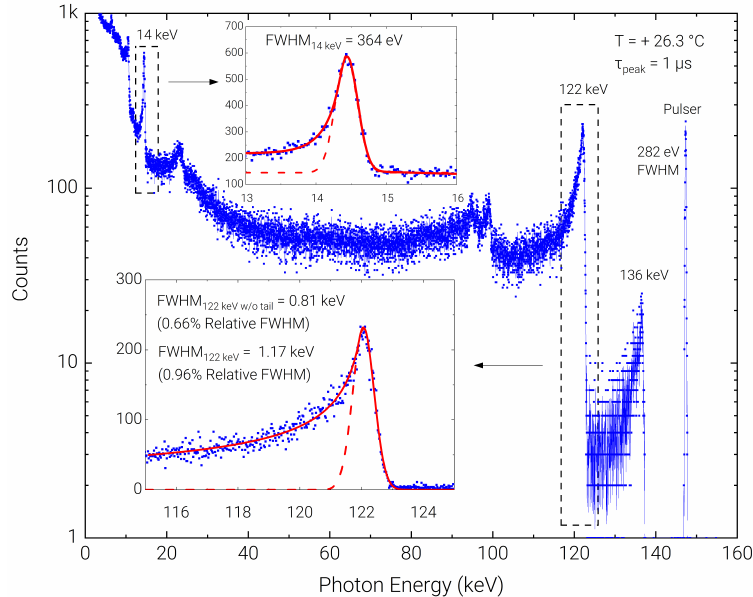
Figure 6. Room temperature spectrum acquired with the 57 Co radioactive source. The presence of long left-hand-side tails, as highlighted in the inset of the 57 Co is minimized when low-energy photons are